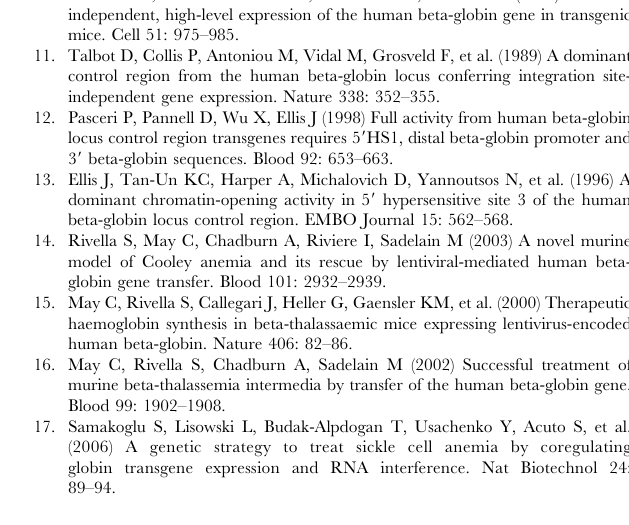
Figure S2 Characterization of MEL cell induction using surface markers of erythroid development. Uninduced and 3 day HMBA treated MEL cells were stained with the following antibodies to detect early (CD117), intermediate (Ery1 and CD71) and late stages (Ter119) of erythroid development. Positive controls include E12.5 mouse fetal liver and Primary Bone Marrow Mastocytes. Method: MEL cells were washed with cold HBSS-2% FBS and stained with a PE-conjugated anti-CD117 (BD Pharmingen Cat.